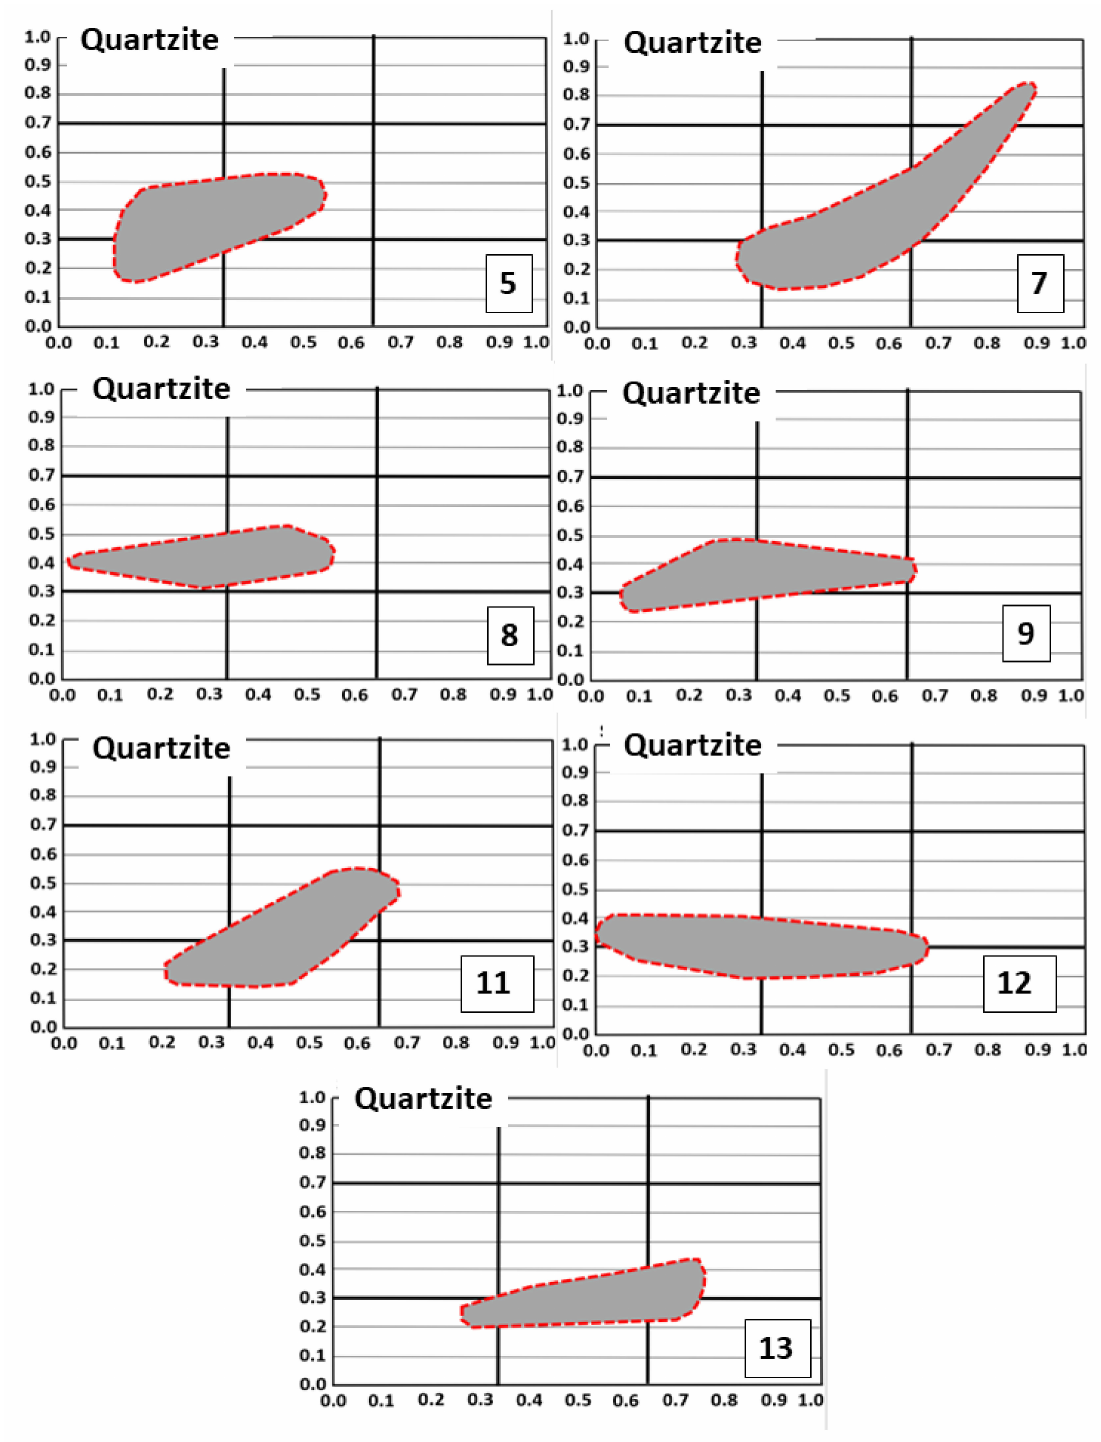
Figure 9. Grain morphology of quartzite lithoclasts as a function of the distance to source given by the site numbers. See also geological base map of Figure